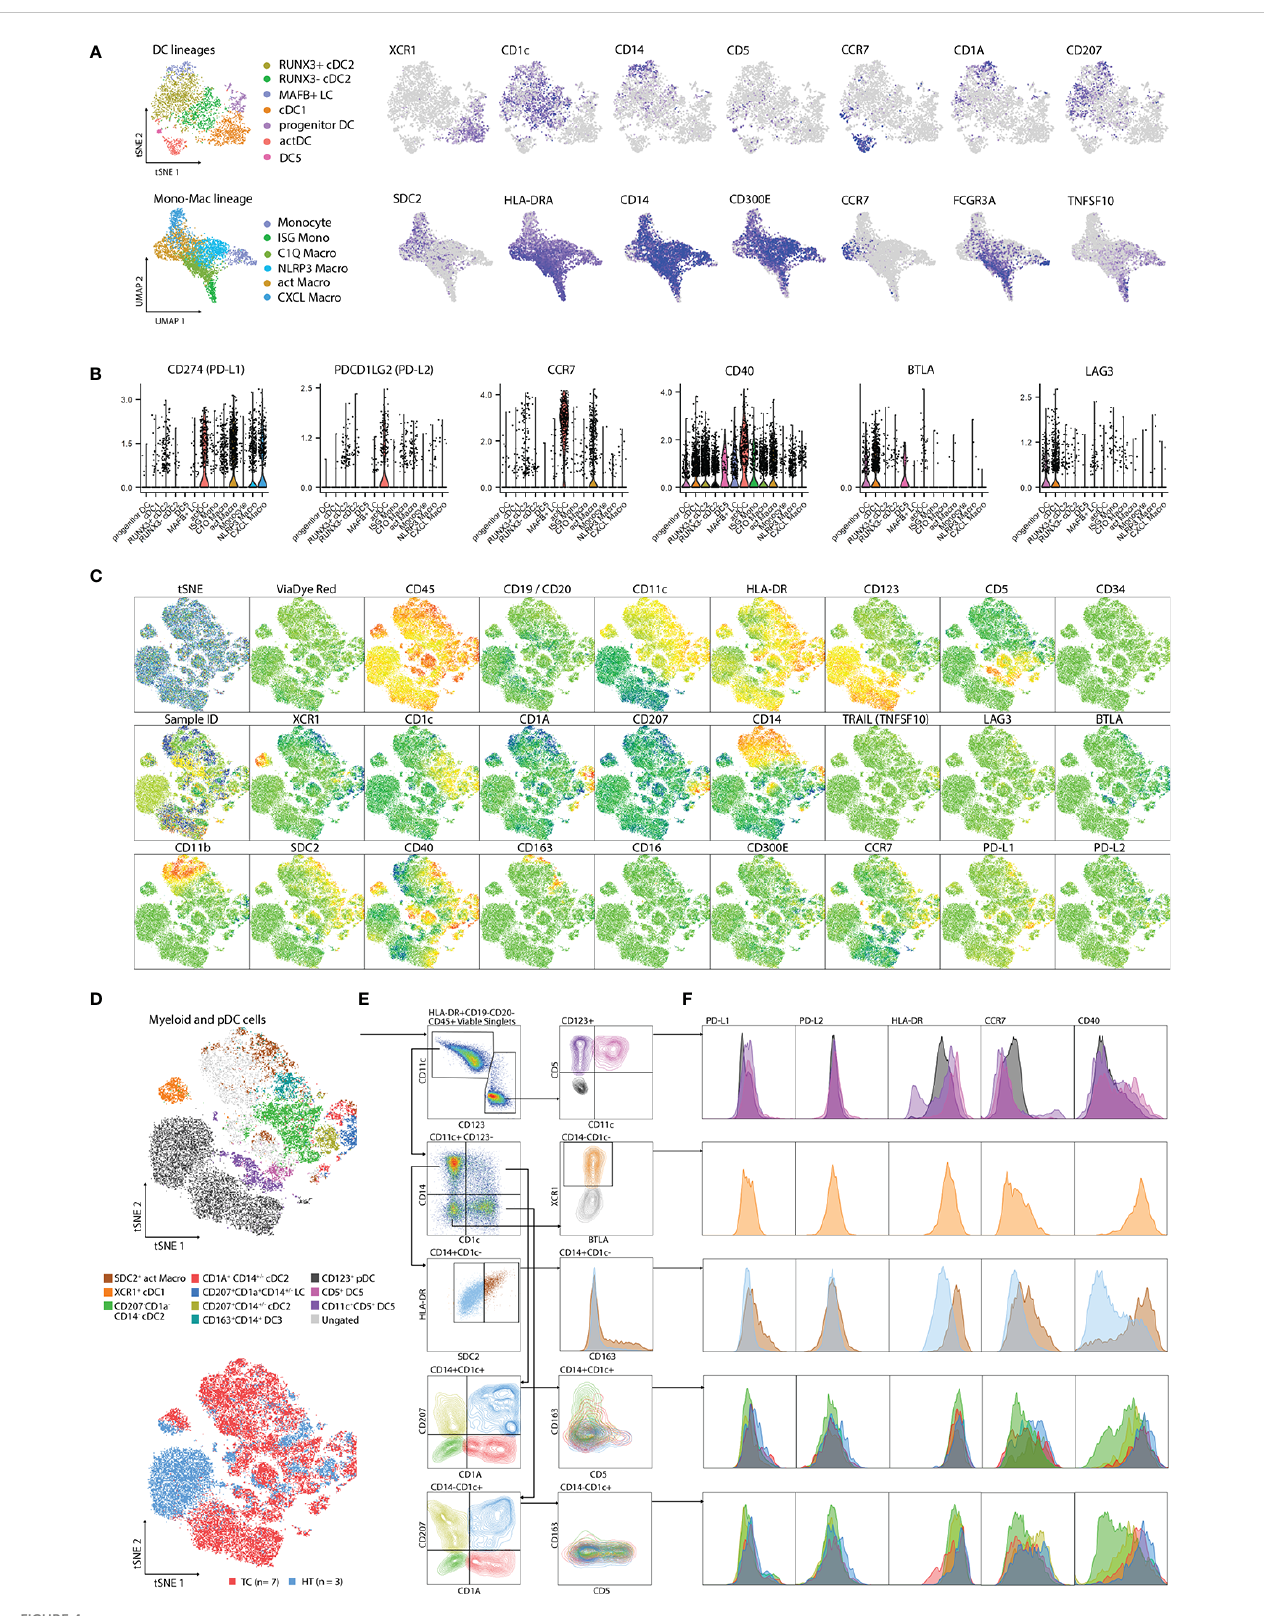
FIGURE 4 Validation of scRNA-seq clusters using 26-plex fl ow cytometry. (A) Gene expression of cluster-speci fi c markers mapping to cell membrane from scRNA- seq analysis. (B) Expression of genes related to APC function from scRNA-seq analysis. (C) tSNE plots showing individual marker expression on 45,712 viable CD45 + HLA-DR + CD19 - CD20 - single cells from TC (n=7) and paired HT (n=3). (D) tSNE plots showing validated populations and their distribution in TC and HT tissues. (E) Gating strategy used to identify scRNA-seq clusters using fl ow cytometry. (F) Expression of genes related to APC function from fl ow cytometry. DC, Dendritic cell; TC, Tonsillar cancer; HT, Healthy tonsil; pDC, plasmacytoid